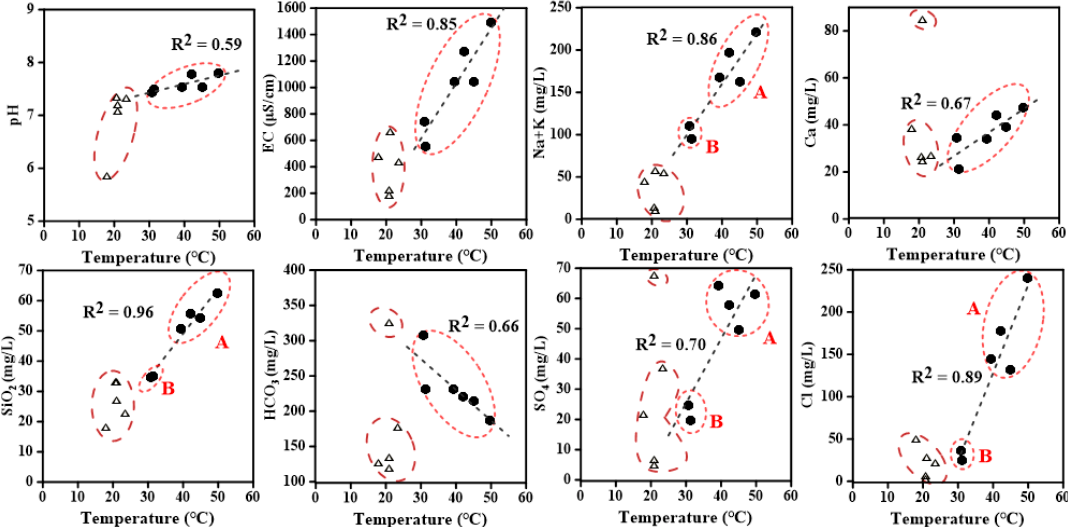
Figure 5. Relationships between chemical parameters and the temperatures of thermal waters (filled circles) and groundwater (open triangles).